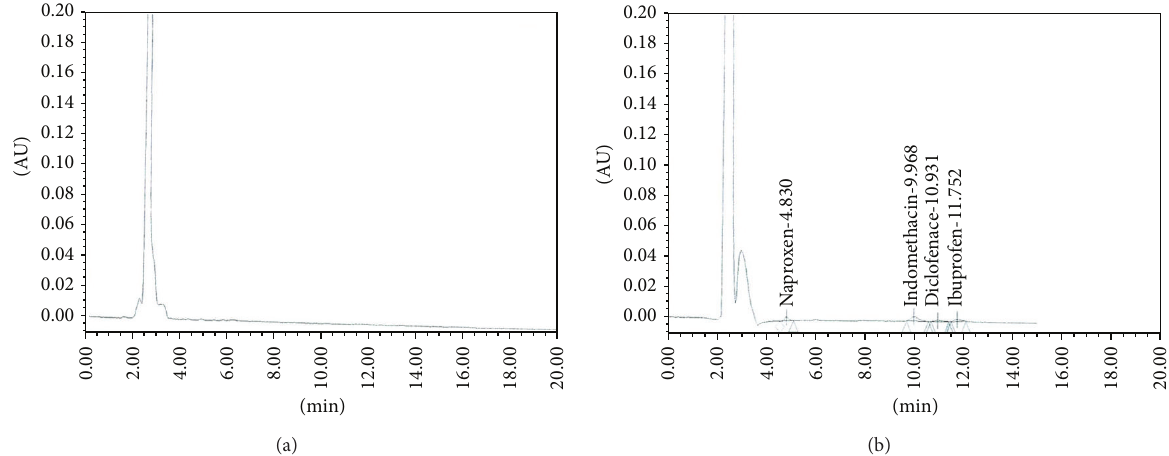
Figure 5: Chromatograms for nonsteroidal anti-inflammatory drugs (a) in an outlet wastewater and (b) in a spike outlet wastewater sample at 25 𝜇 g L −1